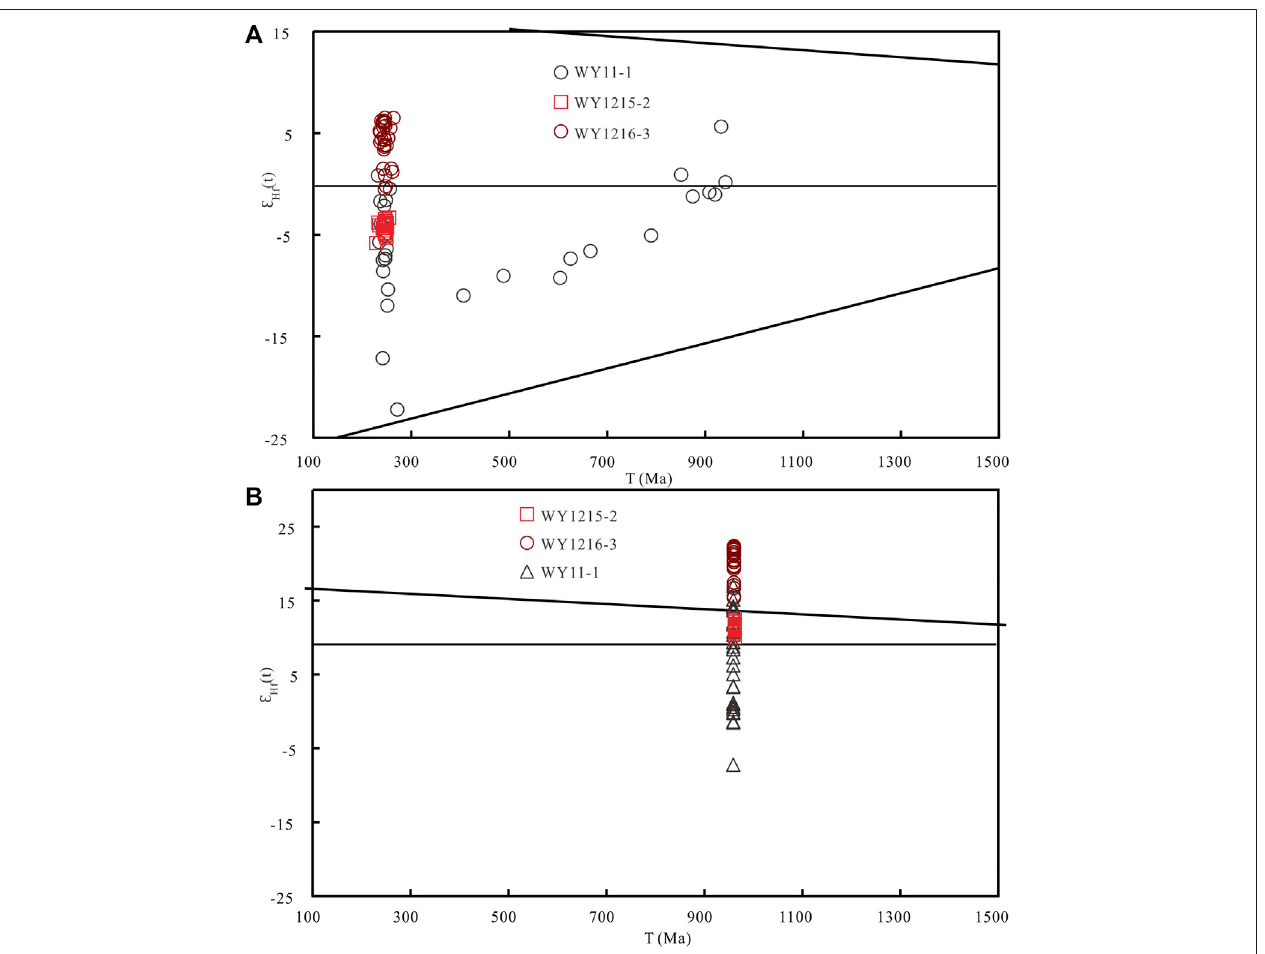
FIGURE 6 | ε Hf (t) value vs . zircon U-Pb age plots of the studied samples.